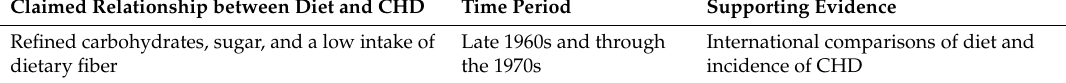
Table 1. Relationship between fat, sugar, whole grains, and coronary heart disease: A summary. Claimed Relationship between Diet and